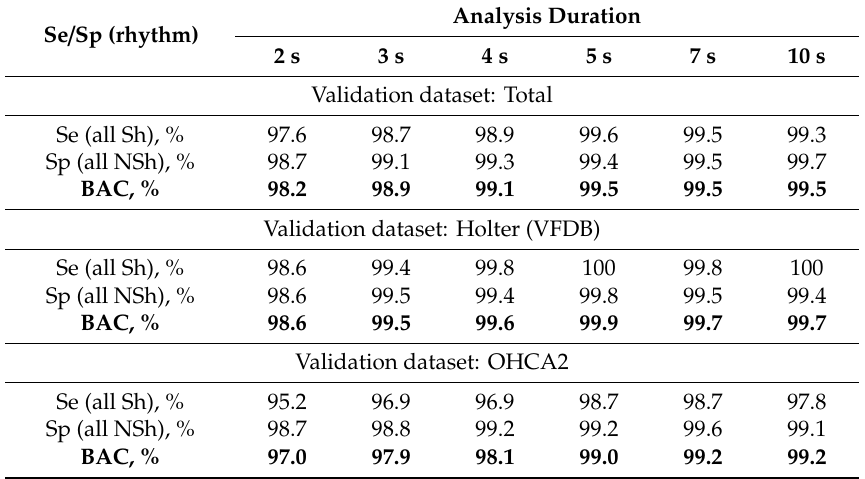
Table 4. Performance of our best CNN model with 2–10 s analysis durations, reported for all rhythms in di ff erent validation